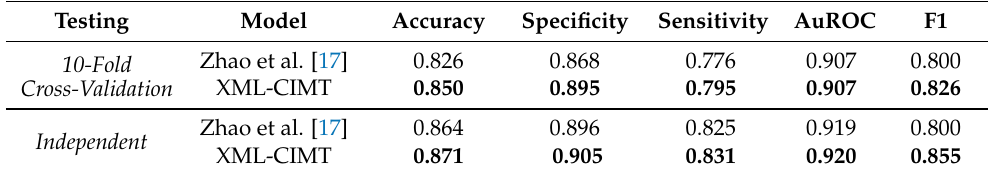
Table 5. Comparison of XML-CIMT with existing state-of-the-art model. (Bold values represent high